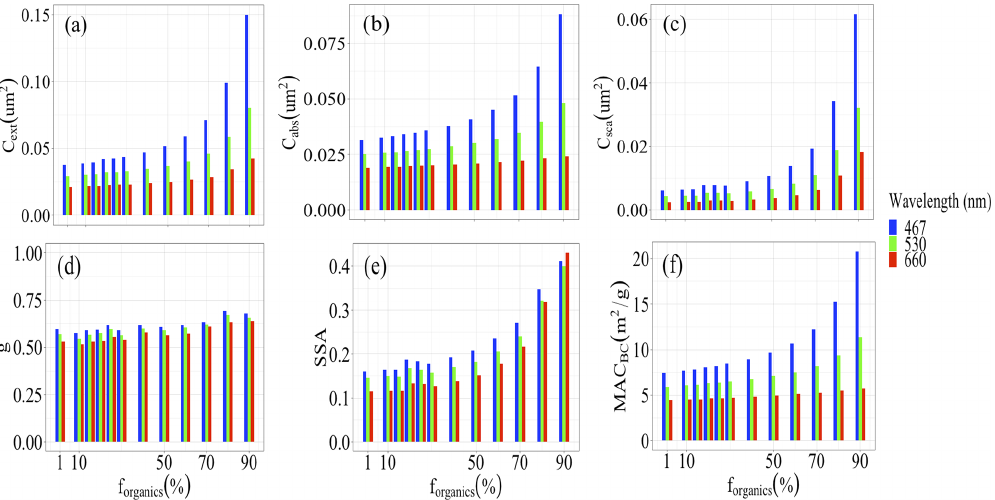
Figure 10. Spectral dependency of coated BCFA optical properties ( N s = 200, D f = 1.7) on fraction of organics ( f organics ): (a) extinction cross section C ext , (b) absorption cross section C abs , (c) scattering cross section C sca , (d) asymmetry parameter g , (e) single-scattering albedo (SSA), and (f) black carbon mass absorption cross section MAC BC . For the variability (%) refer to the case D f = 1.7 in Table